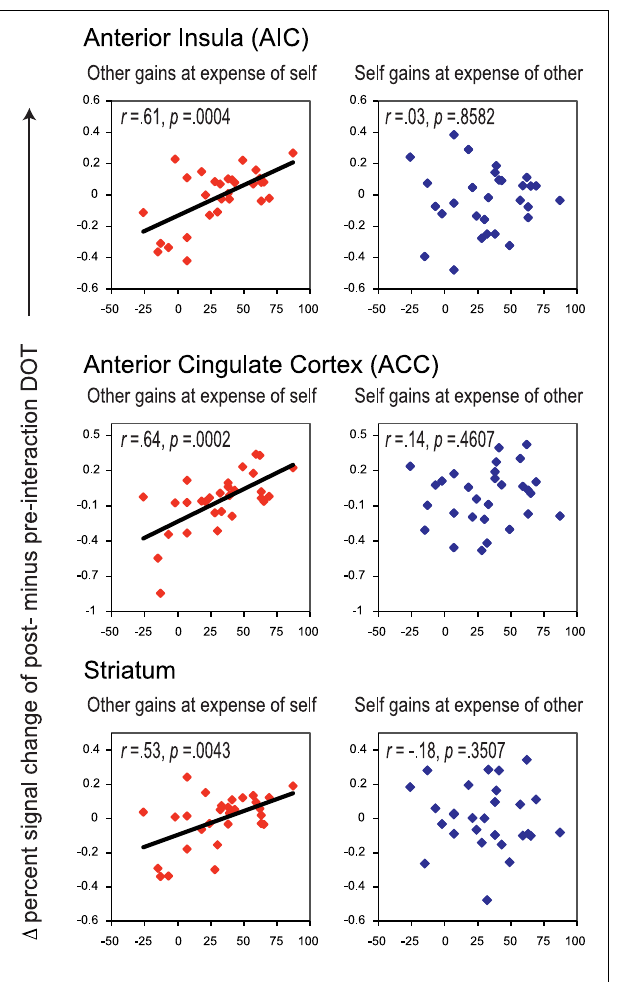
FIGURE 3 | Correlations between empathy scores (BEES) and Δ percent signal change of post- minus pre-interaction DOT. Correlations are shown for AIC (top) and ACC (middle) and striatum (bottom) for trials in which the other gains at the expense of oneself (left panels, in red), and for those in which oneself gains at the expense of the other (right panels, in blue). Correlations before and after public good game interaction separately can be found in Figure 4 . All correlations are listed in Table 4 .